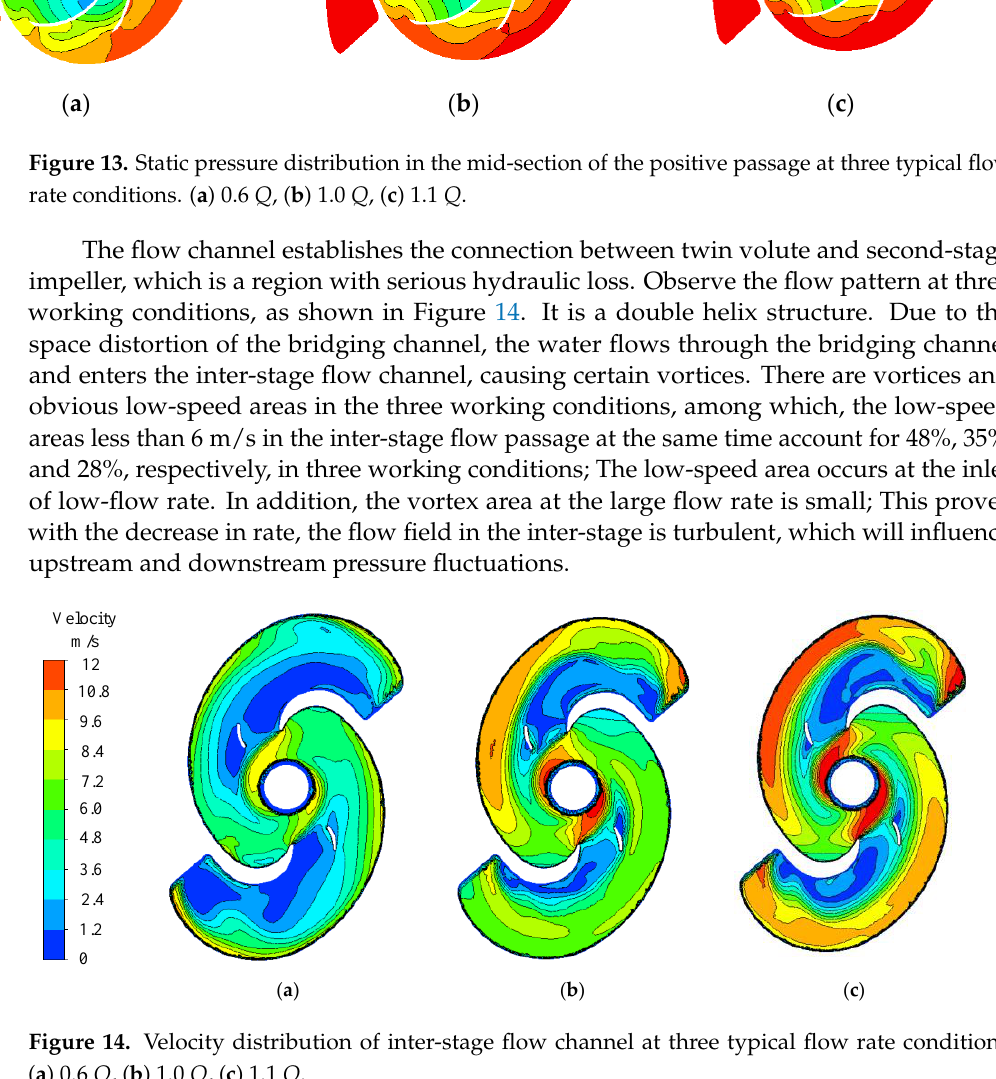
Figure 14. Velocity distribution of inter-stage flow channel at three typical flow rate conditions. ( a ) 0.6 Q , ( b ) 1.0 Q , ( c ) 1.1 Q